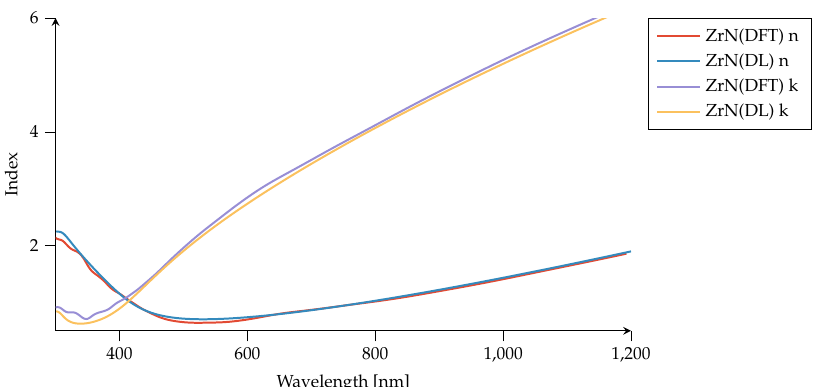
Figure 4. Zirconium nitride (ZrN) comparison of refractive indices ( n , k ). Material models generated via density-functional theory (DFT) [55] are compared to the ZrN material model generated with Drude–Lorentz (DL) parameters using PMCloud’s materials tool. We use (cid:101) ∞ = 0.6.